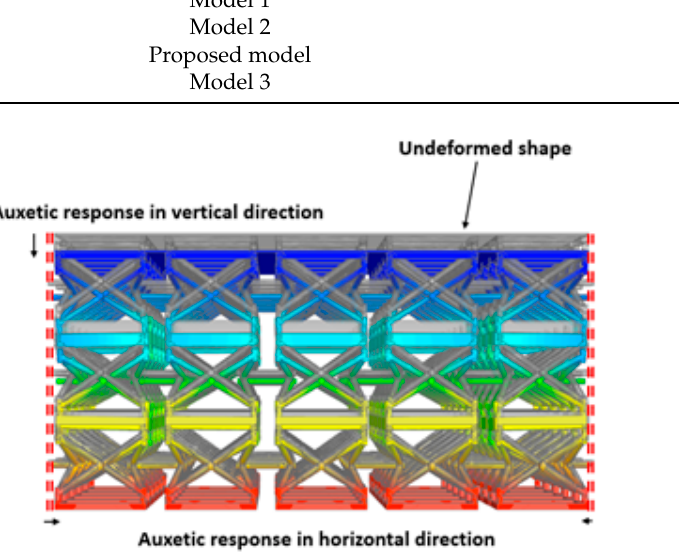
Figure 11. Auxetic deformation behaviour of the meta-functional auxetic composite bridge bearing model in vertical and horizontal directions under compression at vertical displacement of 4 mm.